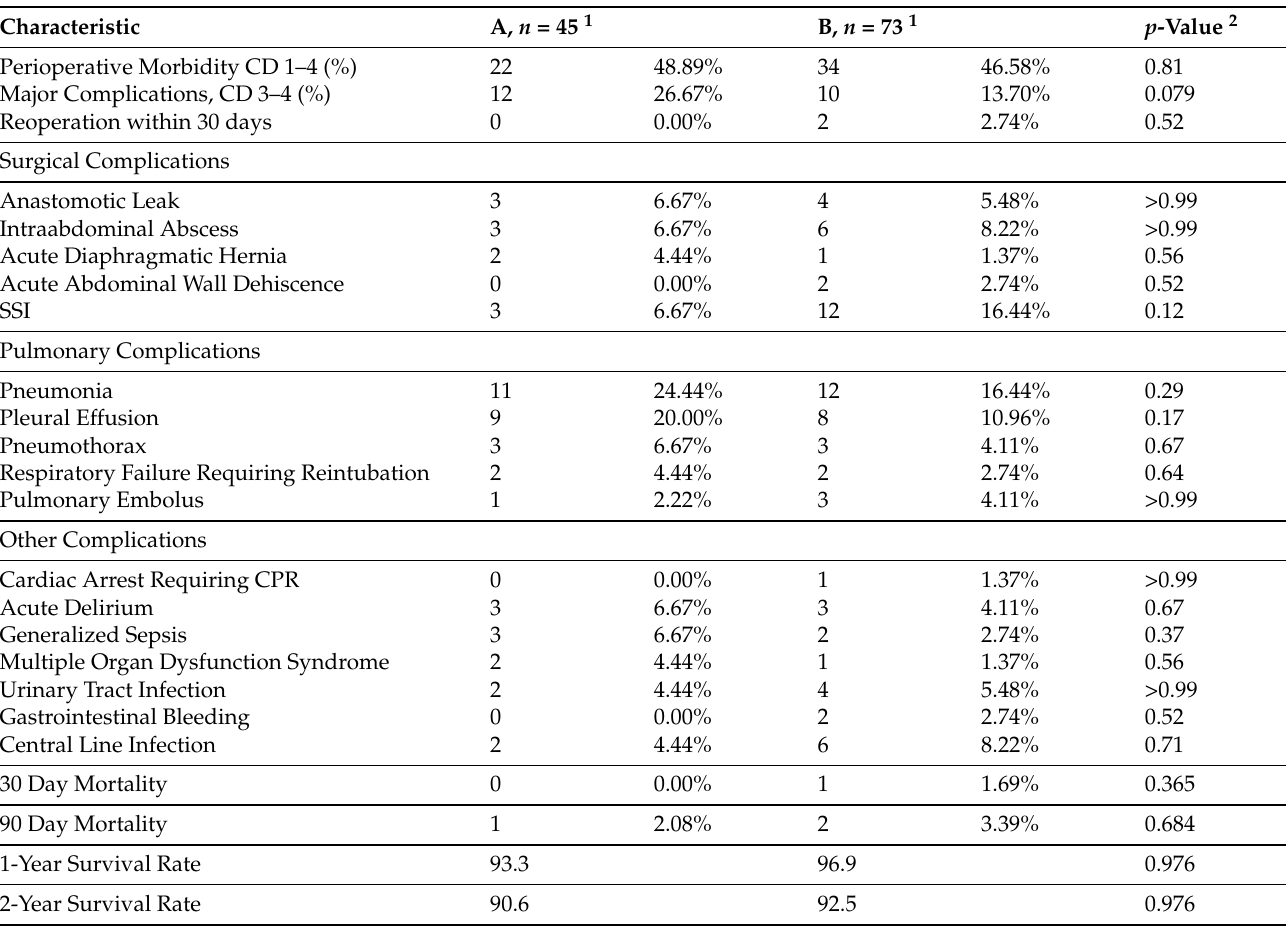
Table 3. Perioperative morbidity and mortality after hand-assisted laparoscopic gastrectomy.